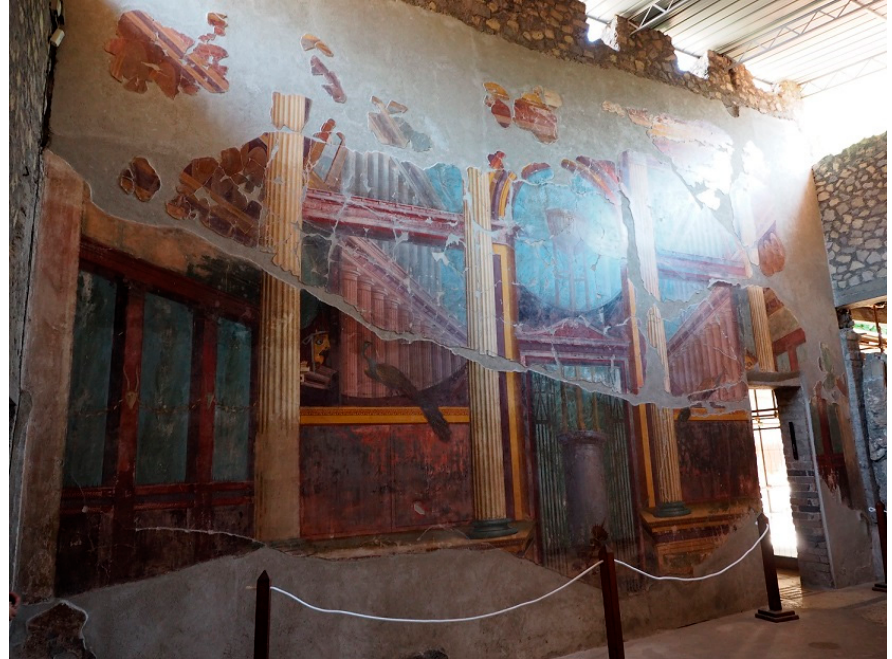
Figure 13. Oblique view on the wall decorated in the second style in oecus 15 from the Villa A of Oplontis (see above Figure 8); © photograph by author.